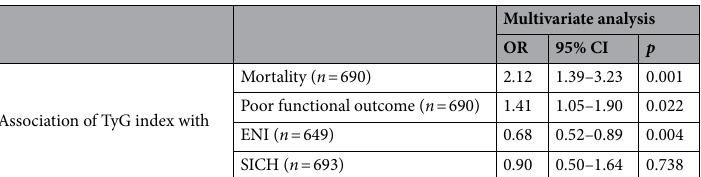
Table 3. Association of TyG index with mortality, poor functional outcome, ENI and SICH. Adjusted odds ratio (OR), 95% confidence interval (CI) and p-value calculated from logistic regression after adjusting for hypertension, age, admitting NIHSS and LVO status. OR odds ratio, 95% CI 95% confidence interval, p p-value, TyG index triglyceride-glucose index, ENI early neurological improvement, SICH symptomatic intracranial